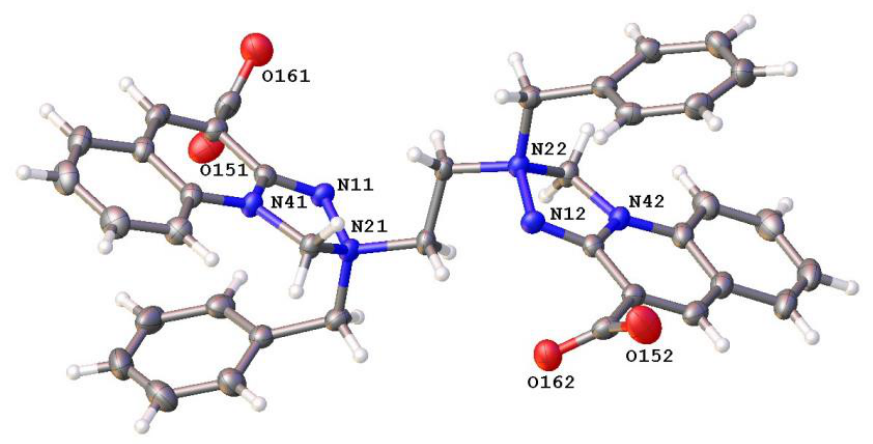
Figure 4. Molecular structure of Safirinium Q dimer 8b . Displacement ellipsoids are shown at the 50% probability level. Only one of the four symmetry independent molecules of 8b is shown.